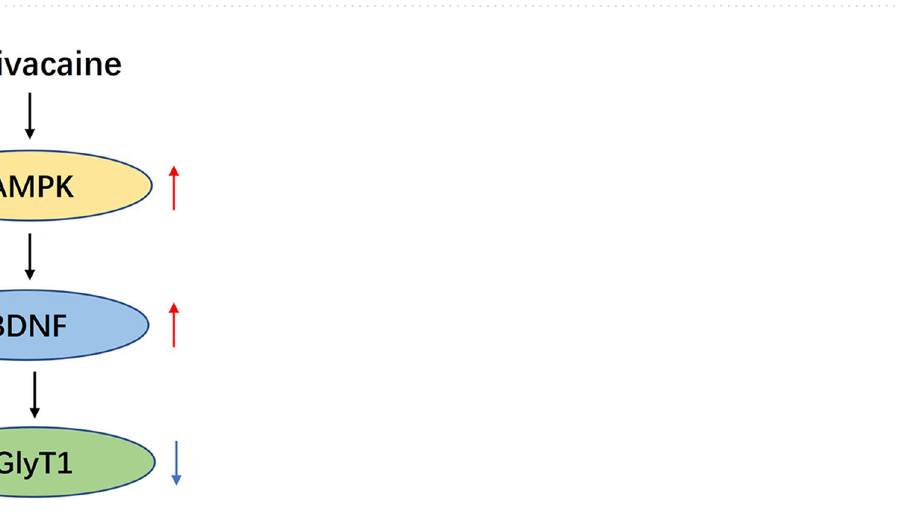
Figure 5. Schematic diagram of the signalling pathways involved in bupivacaine induced GlyT1 reduction in spinal astrocytes. Bupivacaine activated AMPK, and increased the expression of the downstream molecule BDNF to inhibit GlyT1